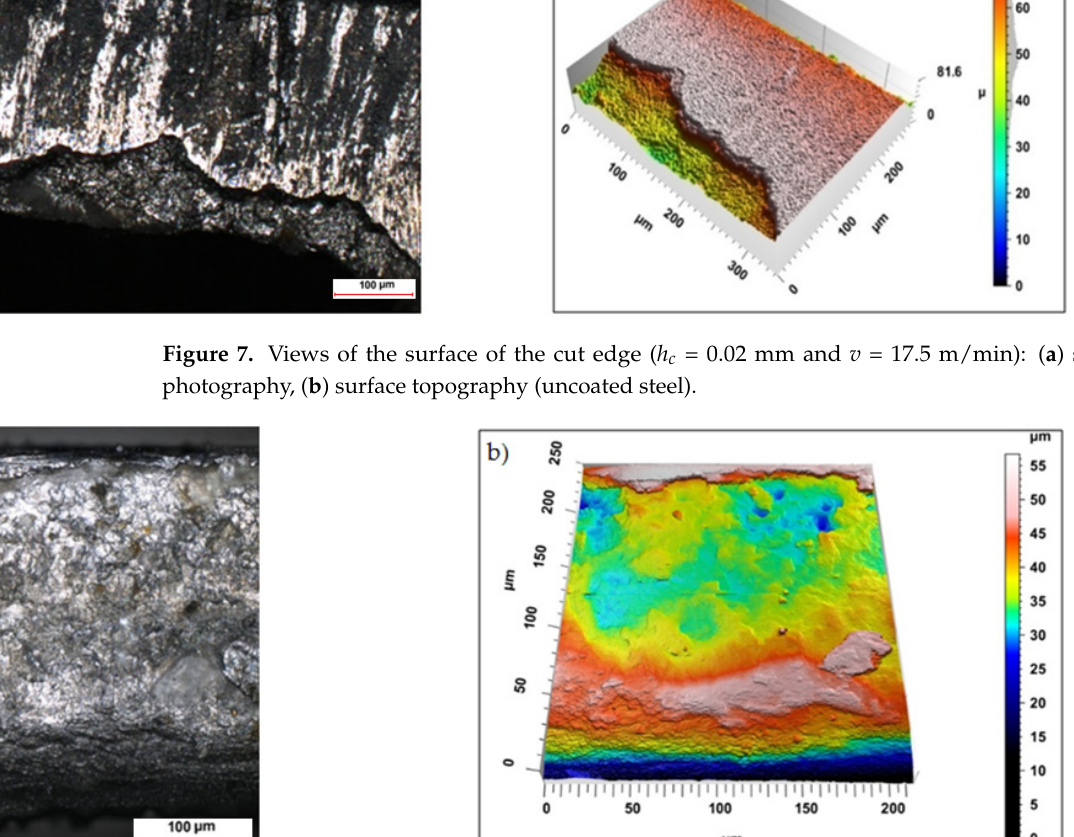
Figure 9. Views of the surface of the cut edge ( h c = 0.06 mm and v = 17.5 m/min): ( a ) surface pho- tography, ( b ) surface topography (uncoated steel).